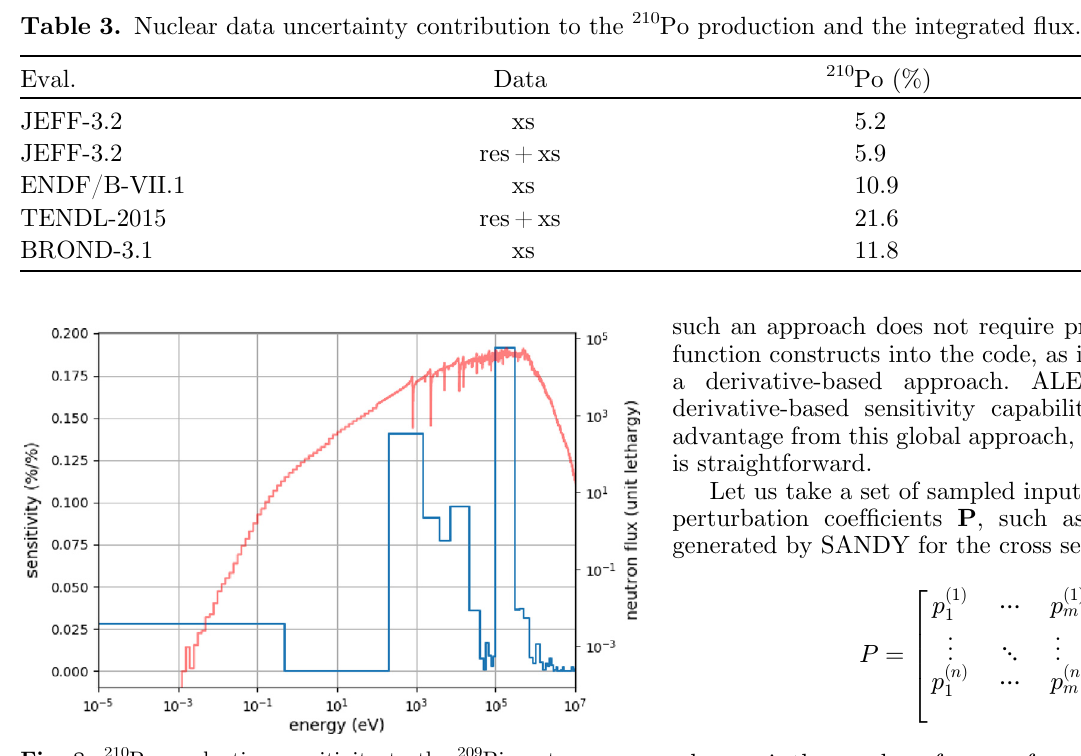
Fig. 8. 210 Po production sensitivity to the 209 Bi capture cross section and neutron fl ux as a function of incident neutron